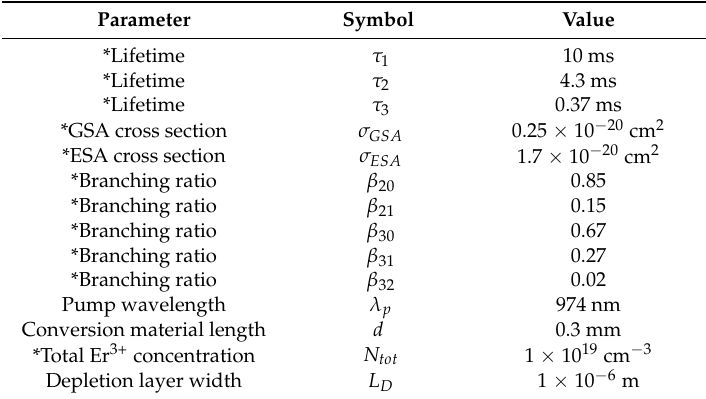
Table 1. Parameters for solving the rate equations. (* obtained from Reference